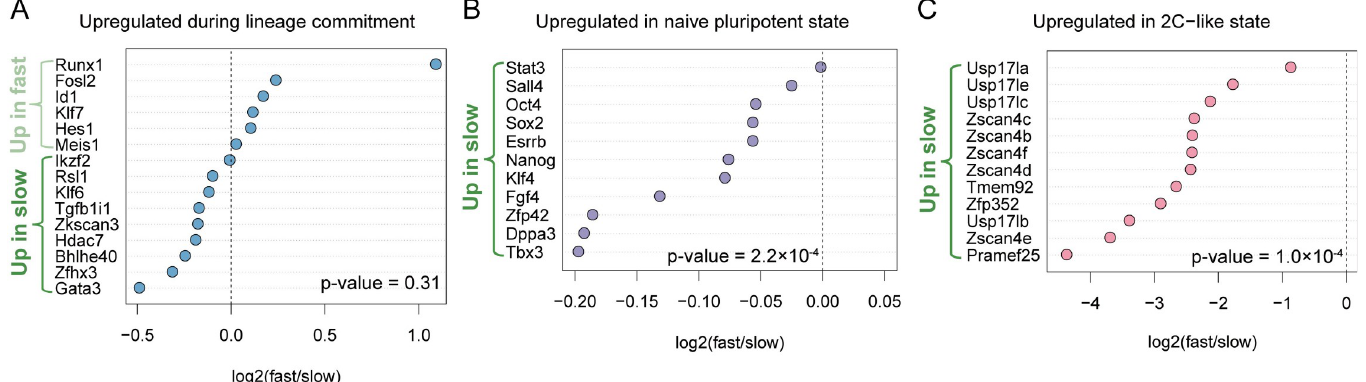
Fig 2. Slow-proliferating ESCs display a more naive pluripotent stemness character than fast-proliferating ESCs. (A) Comparison of lineage commitment-related gene expression between fast and slow proliferating subpopulations. (B) Comparison of pluripotency-associated gene expression between fast and slow proliferating subpopulations. (C) Comparison of 2C-like state markers expression between fast proliferating subpopulation and slow proliferating sub-population. Dashed lines separate genes expressed preferentially in slow- (left of dashed line) or in fast-proliferating (right of dashed line) ESCs. P-values are from binomial tests, testing if genes are more often highly expressed in slow cells than would be expected by chance (53.5% of all genes are more highly expressed in slow cells).